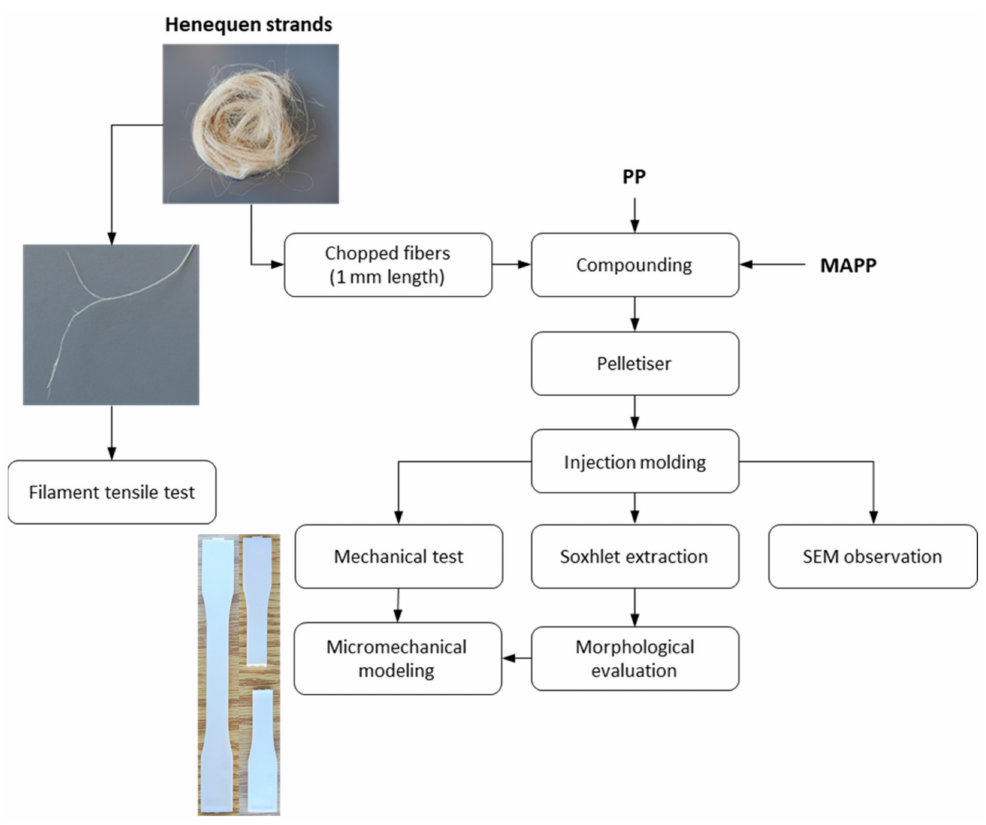
Figure 1. Workflow of the present